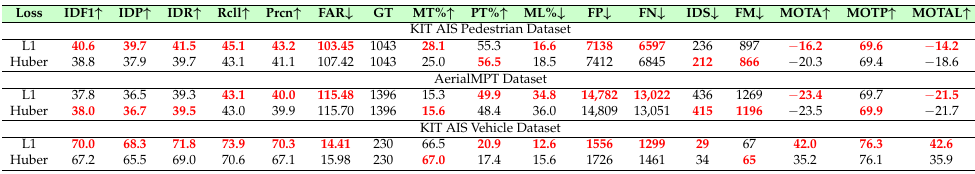
Table 15. Comparison of AerialMPTNet trained with the L 1 and Huber